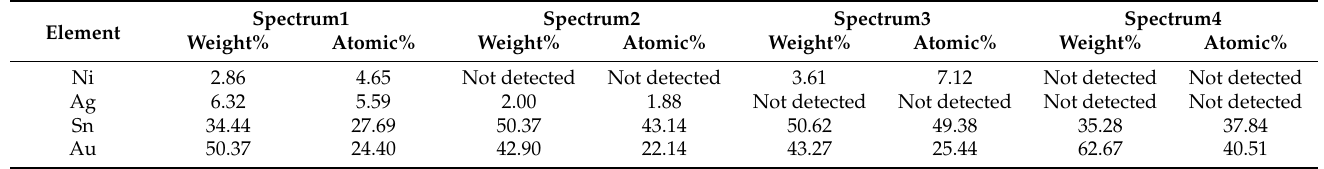
Table 1. The atomic diffusion concentration at the bonded interface.